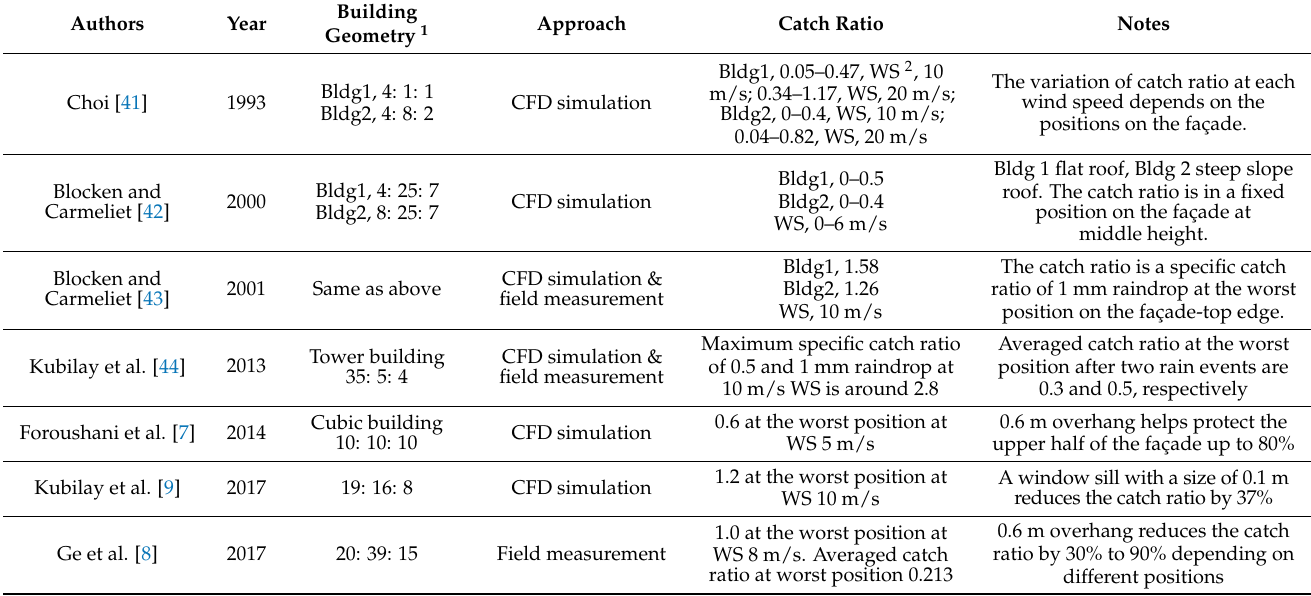
Table 3. Literature review on catch